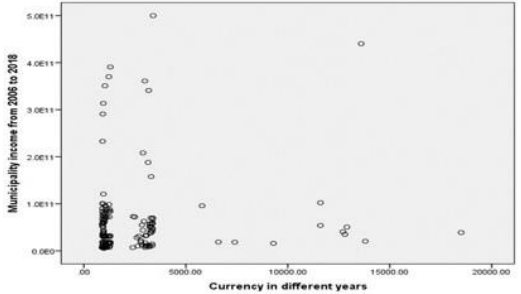
Figure 6. Correlation